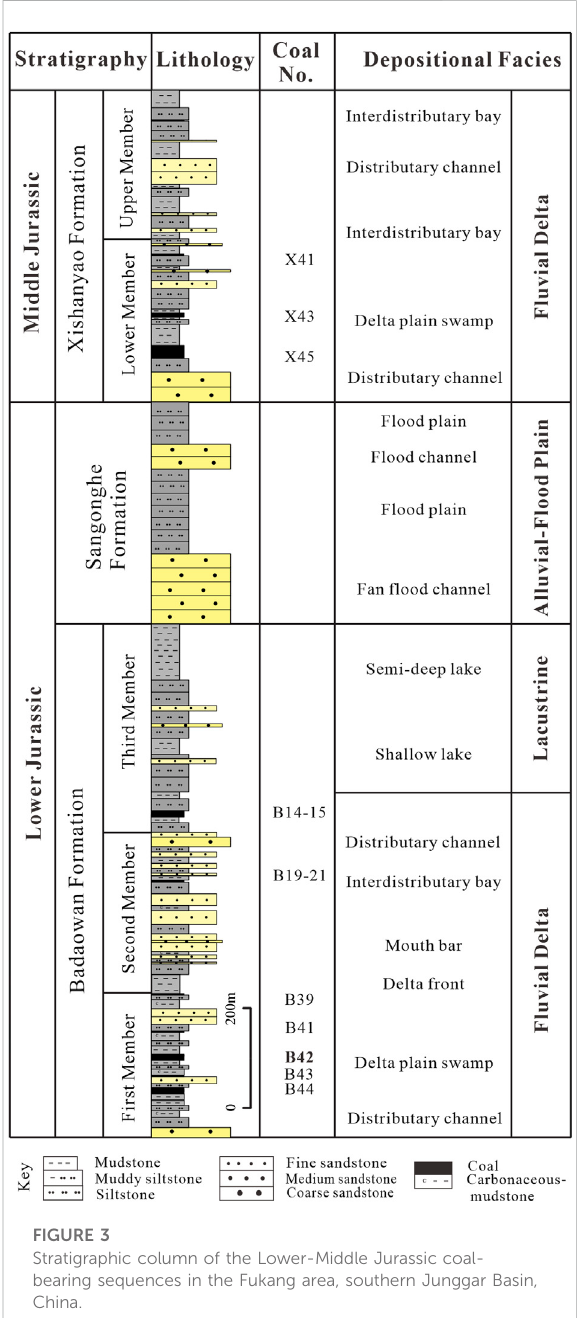
FIGURE 3 Stratigraphic column of the Lower-Middle Jurassic coal- bearing sequences in the Fukang area, southern Junggar Basin,